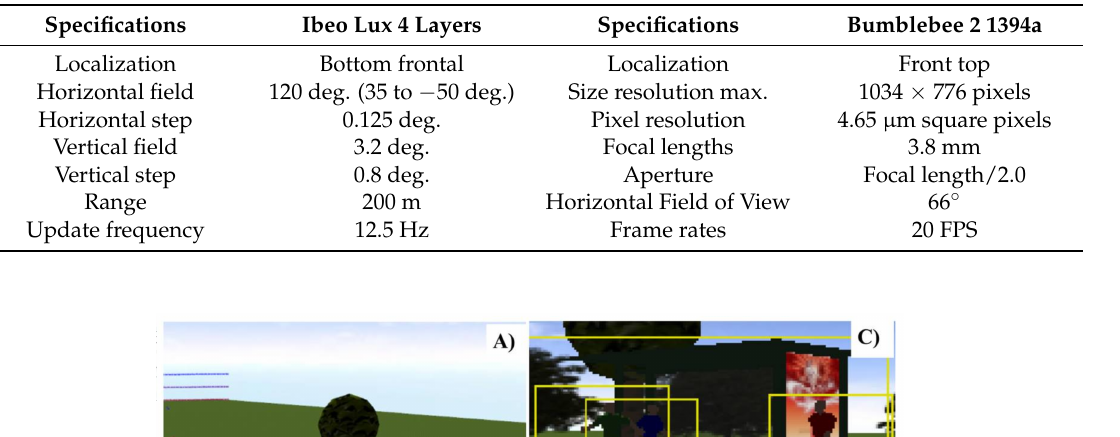
Table 2. Specifications and location of both sensors on the vehicle.